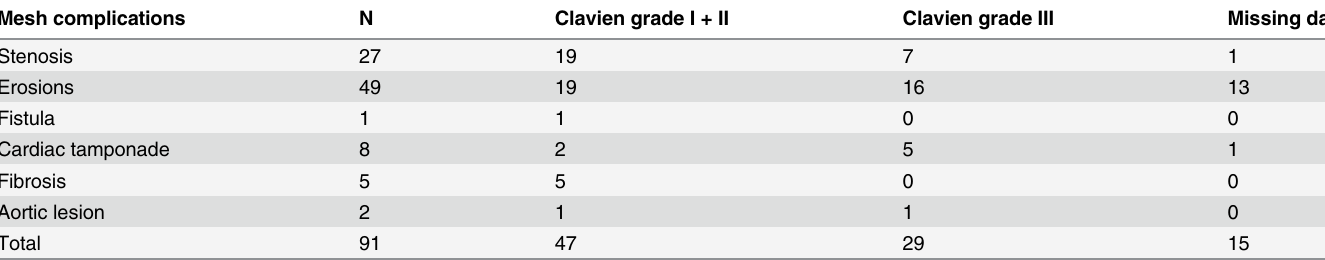
Table 2. Summary of the different types of mesh-associated complications (according to S1 – S3 Tables). Mesh complications